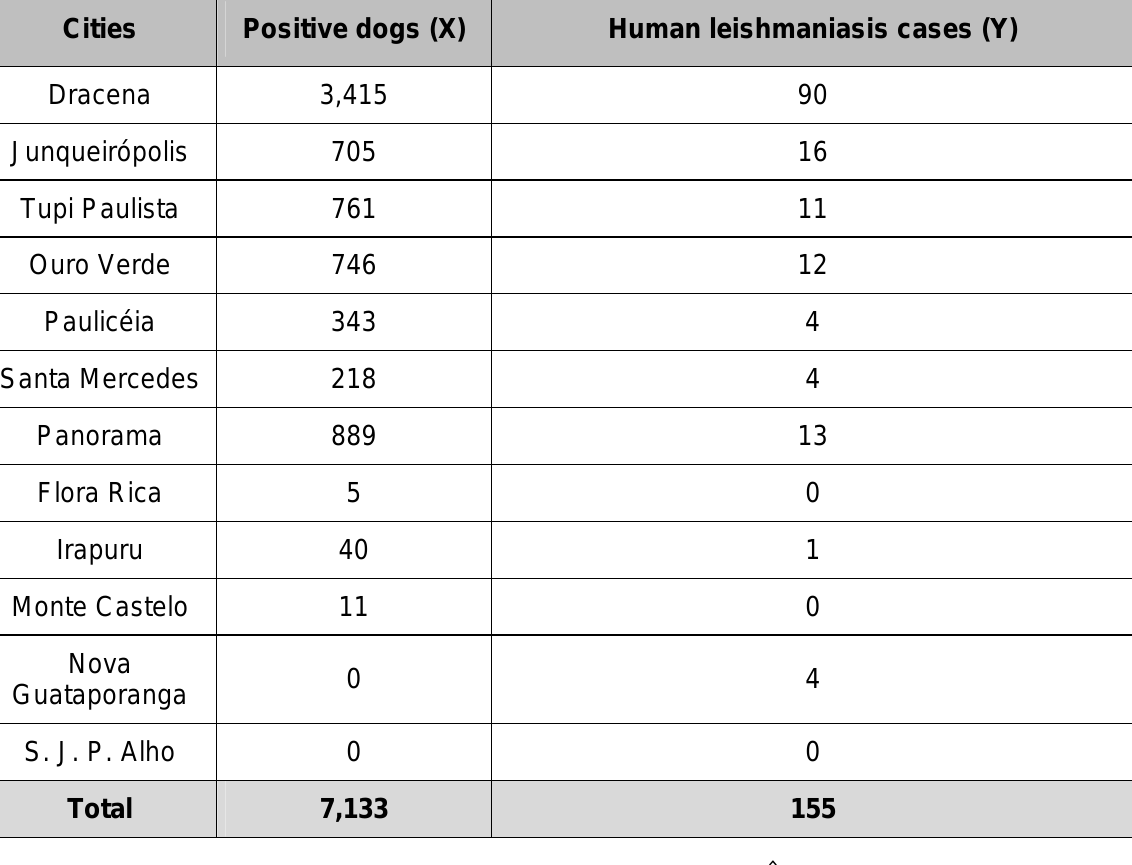
Table 6. Total number of human leishmaniasis cases (Y) and positive results among dogs (X) in Dracena microregion, Alta Paulista (SP), from August 2005